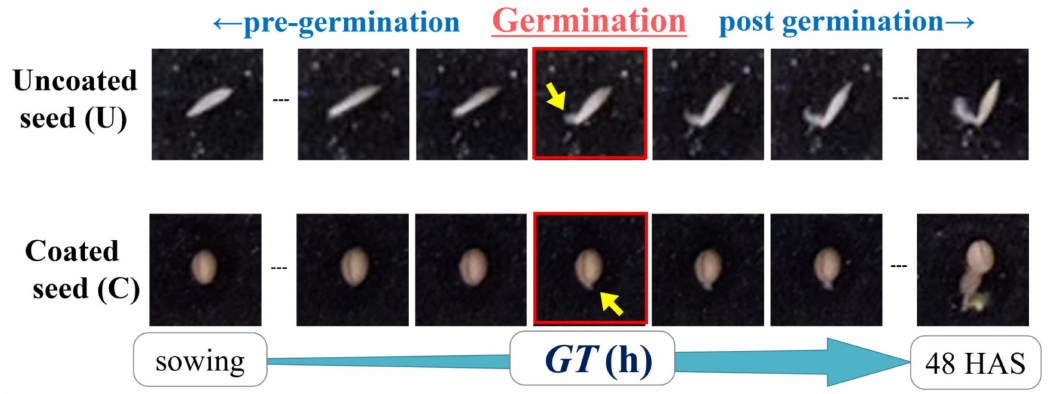
Figure 4. Germination time ( GT ) acquired from time series red-green-blue (RGB) images, obtained continuously from sowing until 48 h after sowing